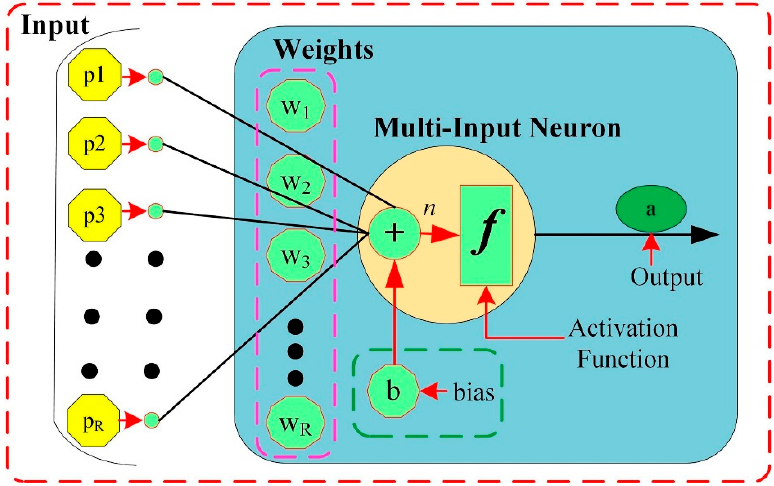
Figure 2. Structure of the multi-input neuron .